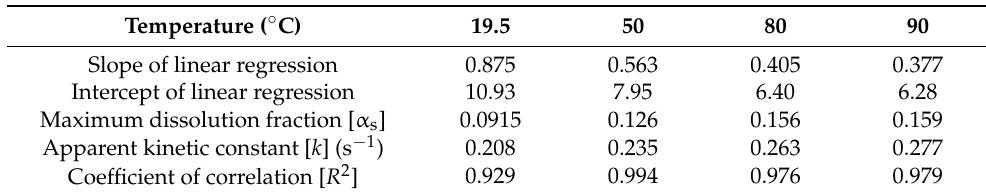
Figure 5. Graphical determination of kinetics constant based on proposed kinetic model at different temperatures: 19.5 °C (circles), 50 °C (squares), 80 °C (diamond), 90° (triangles). Molar liquid to solid ratio: 9.88 (mol DES/mol initial Cu in chalcopyrite). Table 3. Data resulting from fitting Equation (4) to the data in Figure 1. Molar liquid to solid ratio: 9.88 (mol DES/mol initial Cu in chalcopyrite).